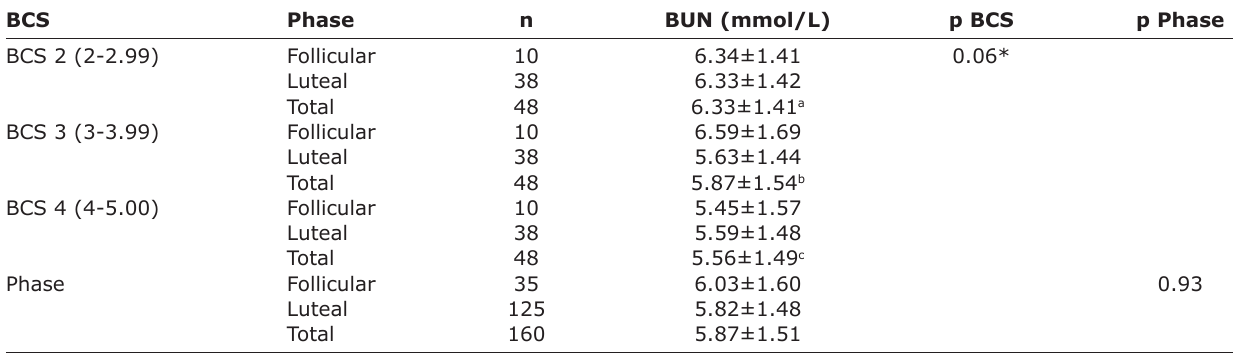
Table-3: Blood urea nitrogen levels of Saanen goats in each body condition score during the phases of estrous cycle (mean±SD). BCS